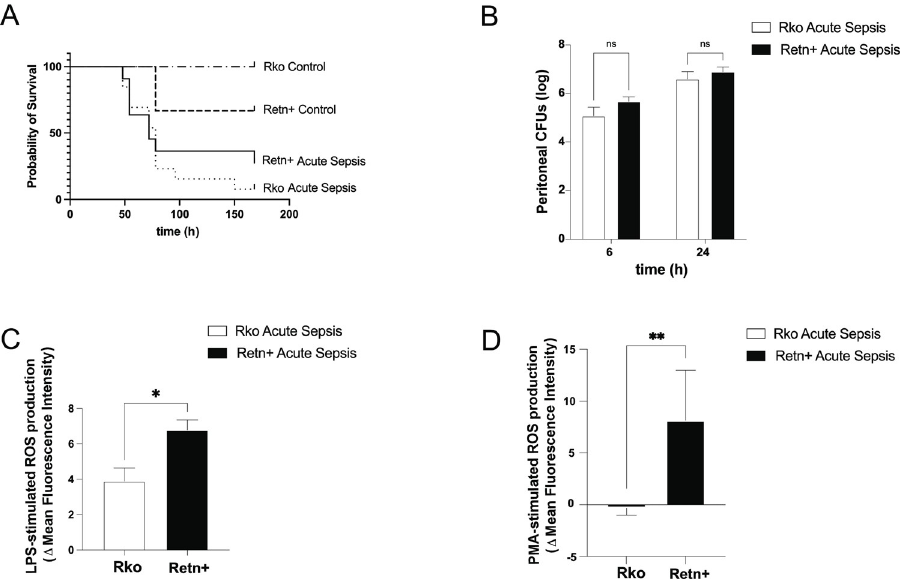
Fig 5. Outcomes for knockout mice (Rko) and those producing human resistin (Retn+) in acute sepsis induced by CLP. A, Kaplan-Meier curve following acute sepsis (time = 0 h), with n = 14 for Retn+ of whom 11 underwent CLP and 3 underwent sham surgery; n = 18 for Rko of whom 13 underwent CLP and 5 underwent sham surgery. High apparent mortality in sham-operated Retn+ is attributed to one mortality in a group with n = 3, which we surmise to be an outlier. B, Peritoneal bacterial load in relation to expression of human resistin. There was no bacterial overgrowth in Rko as compared with Retn+ mice with sepsis. n = 4 for Rko and n = 3 for Retn at 6 h; n = 9 for Rko and Retn+ at 24 h. C, Change in fluorescence intensity between neutrophils stimulated with PMA and unstimulated cells following exposure to CellROX reagent at 24 h following CLP (n = 6 for Rko and Retn+ mice). D. Change in fluorescence intensity between neutrophils stimulated with LPS and unstimulated cells following exposure to CellROX reagent at 24 h following CLP (n = 6 for Rko and Retn+ mice).